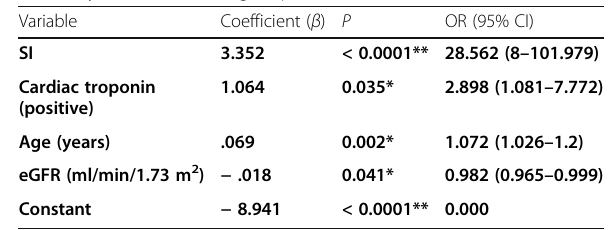
Table 6 Multivariate logistic regression model in prediction of mortality in the studied